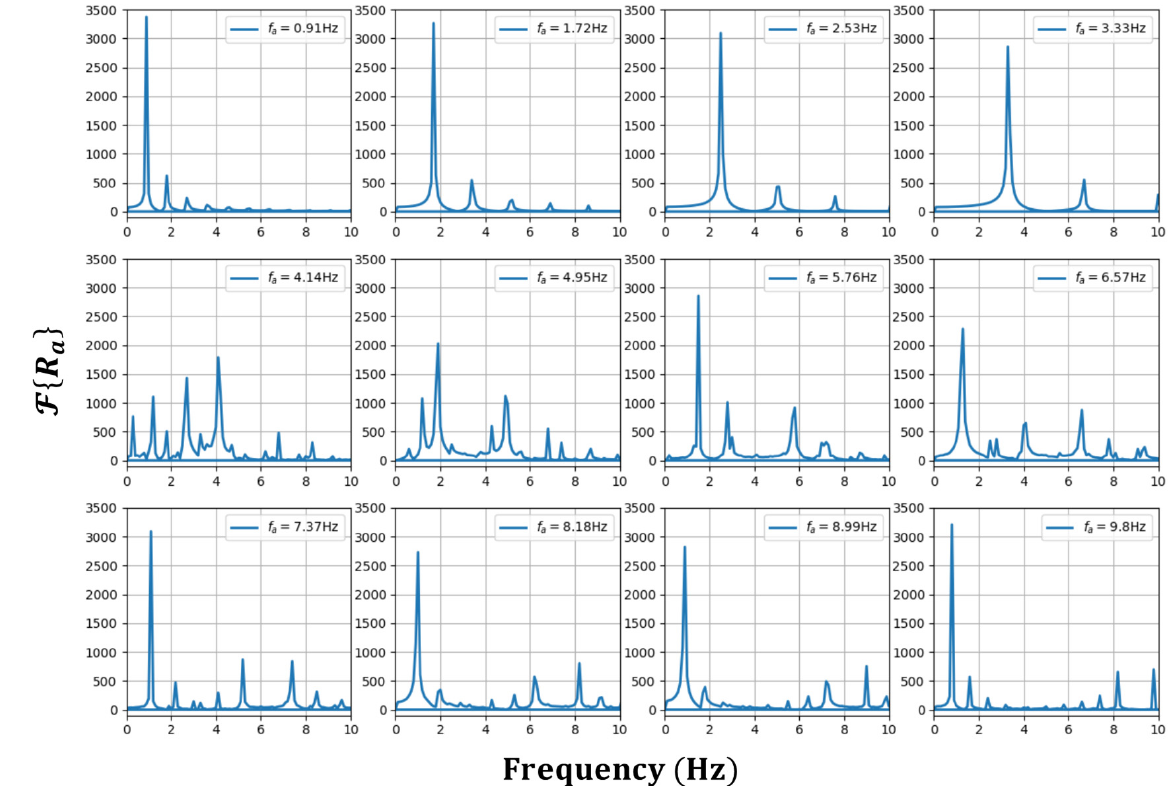
Figure 5. Analyzed frequency components of 𝑹 𝒂 with changes in 𝒇 𝒂 = 𝒂/𝟐𝝅 .